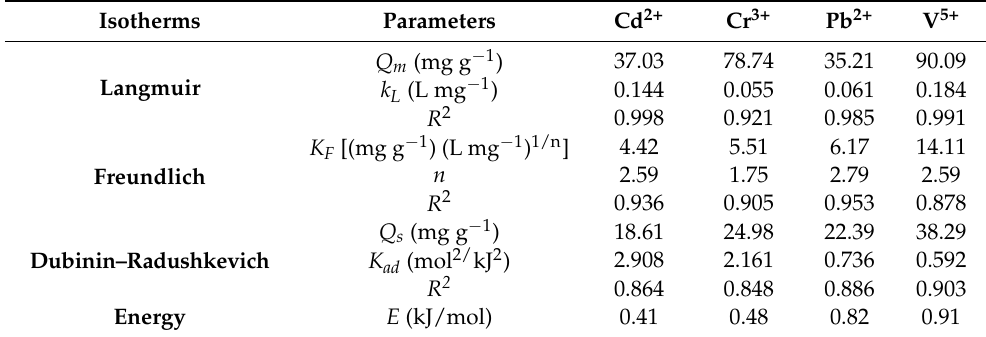
Table 2. Langmuir, Freundlich, DR models and free Energy for adsorption of selected heavy metal ions over AC-SML nanocomposite.